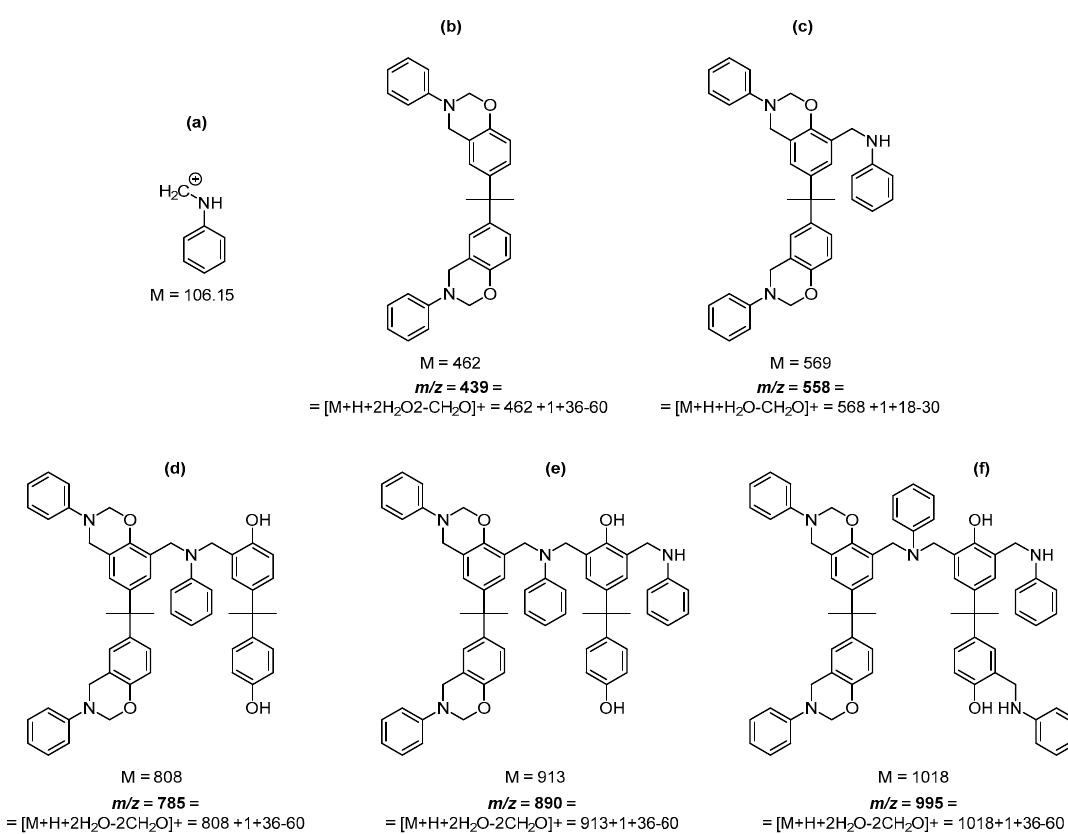
Figure 4. Ion structures and their m / z values formed during mass spectrometry with electrospray ionization of BA-a benzoxazines obtained according to the Scheme 1.: iminium ion derived from phenylaminomethylene fragment ( a ); fragments with one ( b , c ) and two ( d–f ) bisphenol moieties.